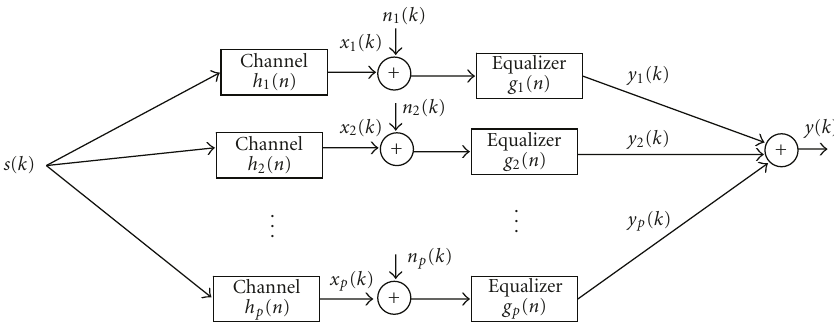
Figure 1: SIMO blind channel estimation and